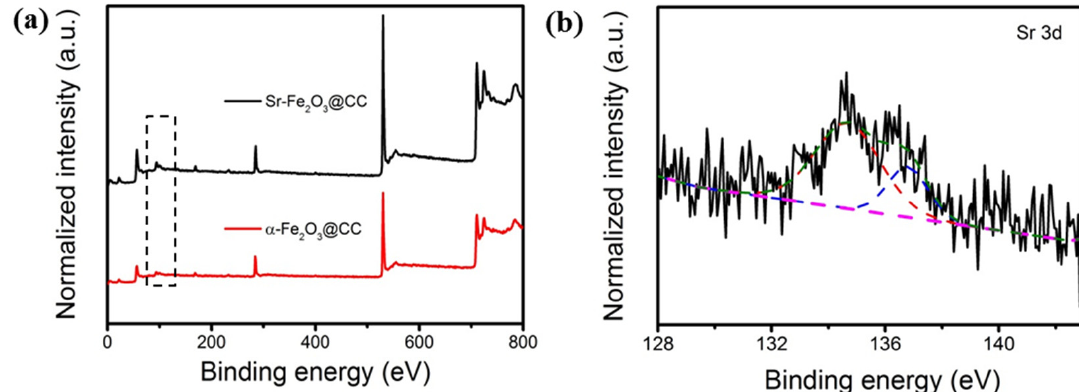
Figure 3. ( a ) XPS survey spectra of α -Fe 2 O 3 @CC and Sr-Fe 2 O 3 @CC. ( b ) Sr 3d core-level XPS spectra for Sr-Fe 2 O 3 @CC.